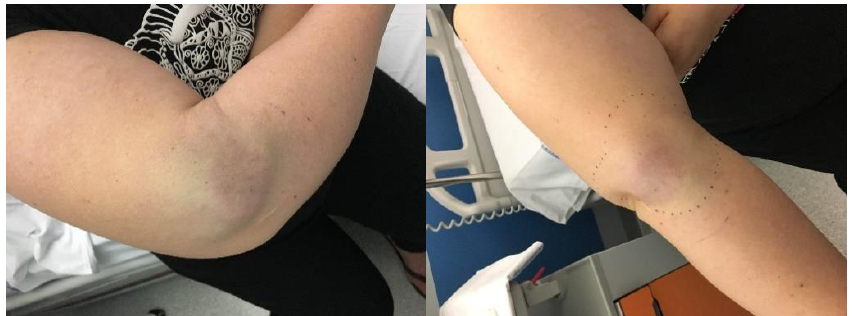
Figure 5. Patient with MCC. Lesion diameter 5 × 6 cm.